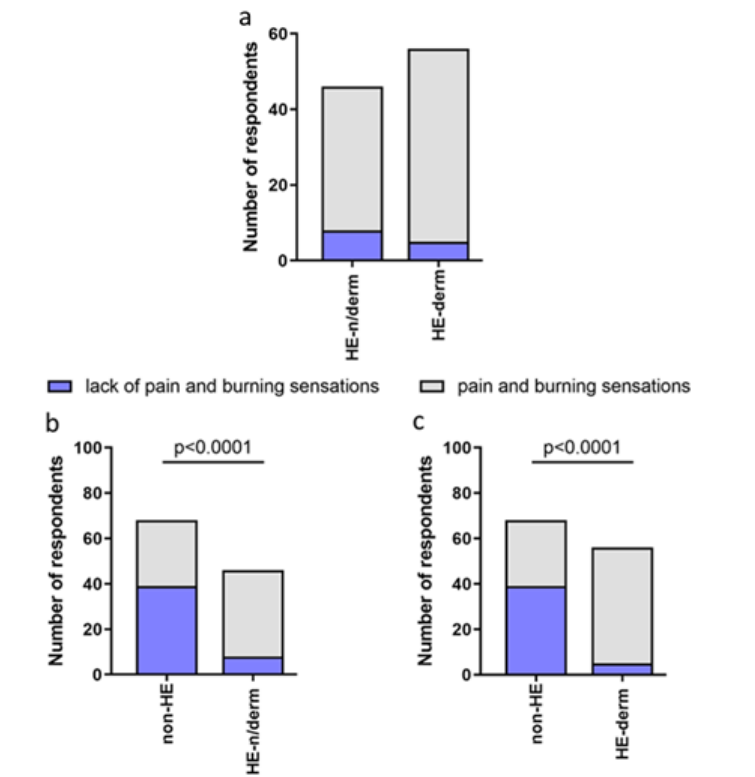
Figure 10. Comparison of the frequency of pain and burning sensations after using disinfectants in study groups: ( a ) HE-n/derm vs. HE-derm; ( b ) non-HE vs. HE-n/derm; ( c ) non-HE vs. HE-derm.